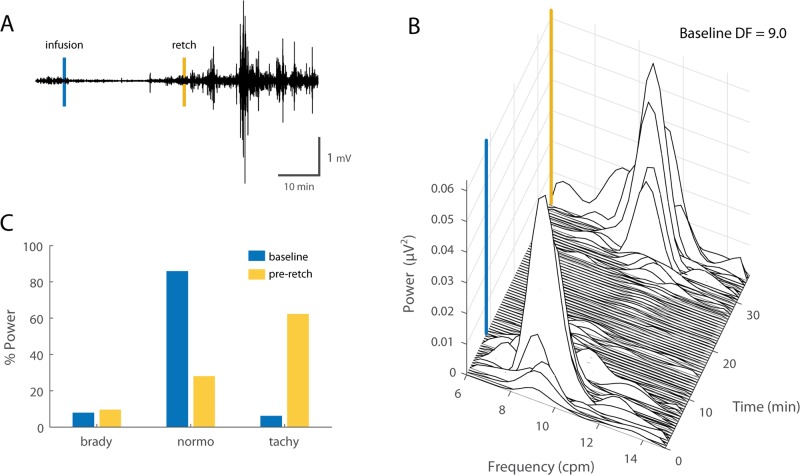
GI myoelectric activity recorded from segment 3 during emetine infusion.A) Example of a 70 min filtered and downsampled GI myoelectric recorded from segment 3 of an anesthetized ferret during emetine infusion trials. Emetine induced retch (yellow line) is observed approximately 28 min post emetine infusion (blue line). B) Waterfall plot of the power spectral density for the waveform shown in A. Each time window corresponds to the FFT of 1 min of GI myoelectric data. C) Percentage of total power in the 6–15 cpm range partitioned by bradygastric (6–8 cpm), normogastric (8–10 cpm) and tachygastric (10–12 cpm) ranges for a signal with a DF of 9 cpm at baseline versus 20 min prior to the first emetine induced retch.